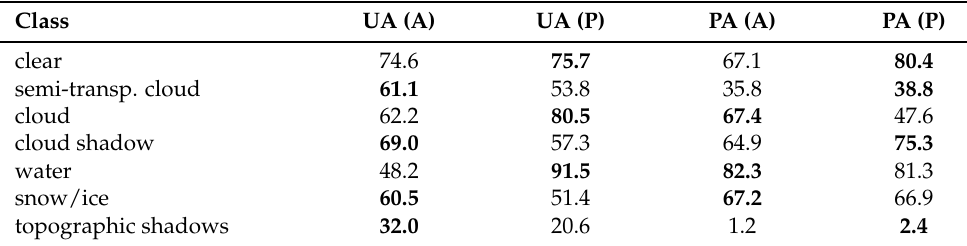
Table 2. Summary of classification accuracy (percent) for difference area (A = ATCOR, P = PACO; bold face numbers indicate the best performances).